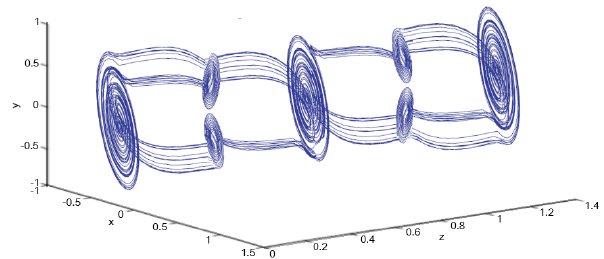
Figure 7. A chaotic attractor with seven scrolls. The 7-scroll attractor is generated by (2.4) via the series switching technique with the parameter values ( b, d, W ( η )) = (cid:0) 1